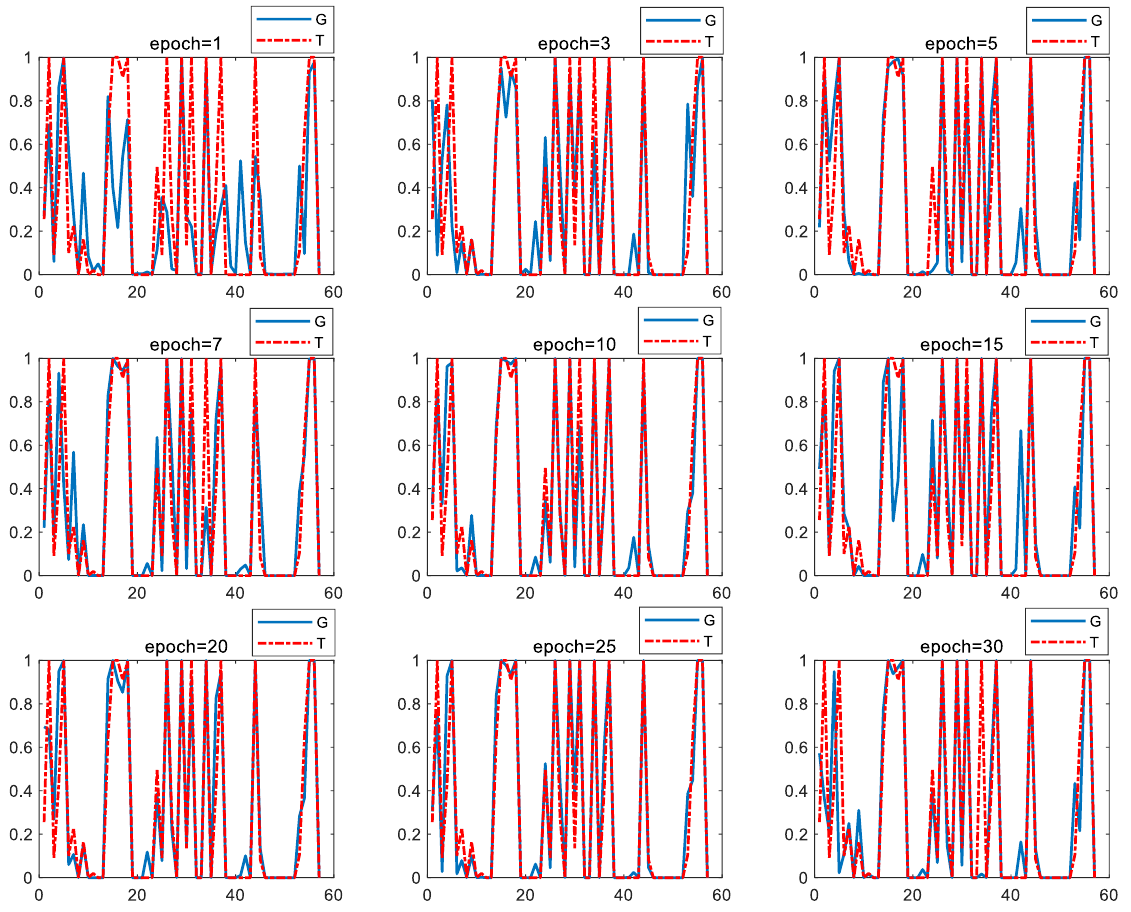
Figure 6. Comparison of the generated and real sample features at different epochs.